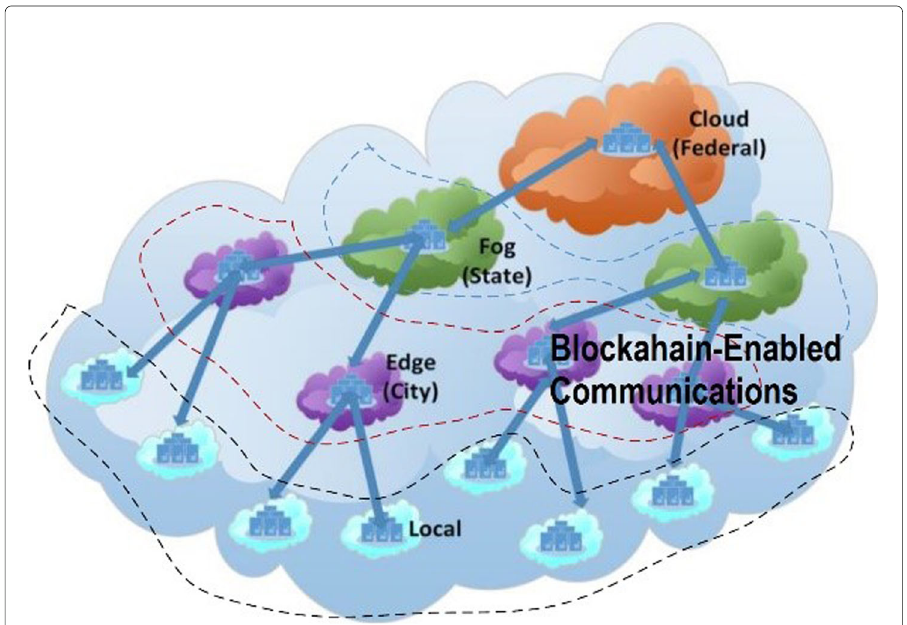
Fig. 1 Blockchain within Federated Cloud Architecture (Malomo et al.